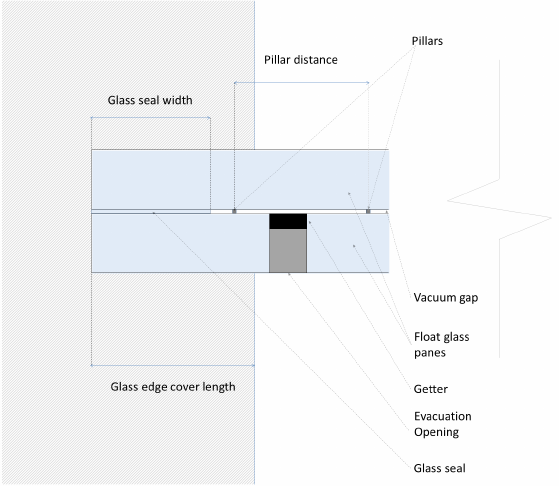
Figure 2. Terminology of the major constituents of vacuum glass